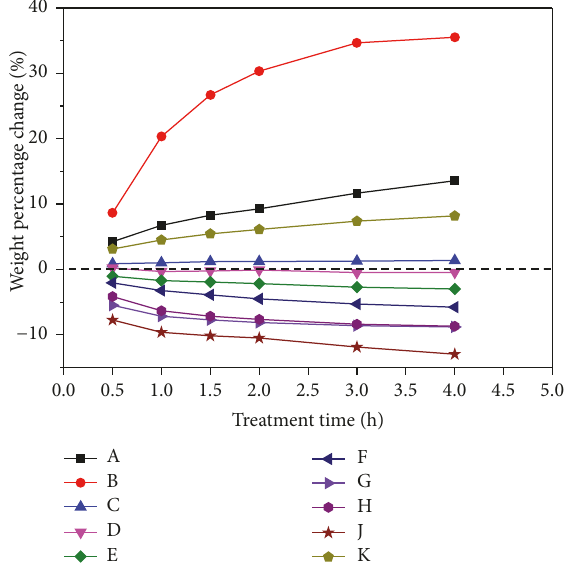
Figure 3: Weight percentage change of bamboo scrimbers in different media at different treatment temperatures. A, B, and K: water immersion at 63 ∘ C, 100 ∘ C, and 25 ∘ C; C and D: oil immersion at 100 ∘ C and 150 ∘ C; E, F, and G: air drying at 63 ∘ C, 100 ∘ C, and 150 ∘ C; H and J: infrared drying at 100 ∘ C and 150 ∘